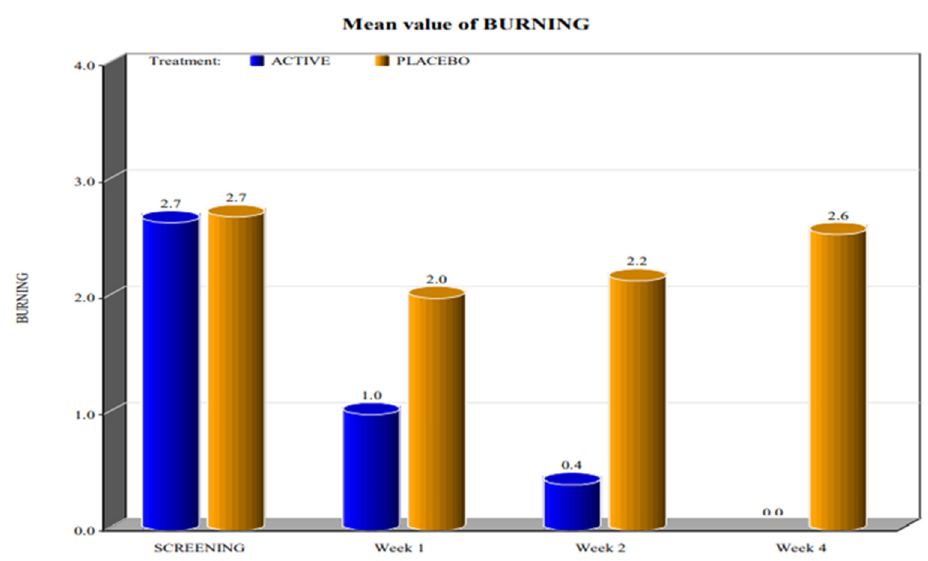
Figure 2. Mean value of burning ( p value < 0.0001).